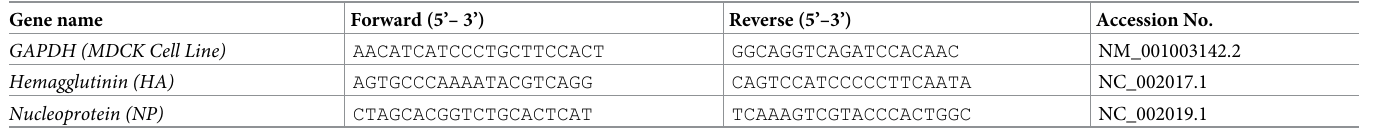
Table 1. Primer list of RTqPCR